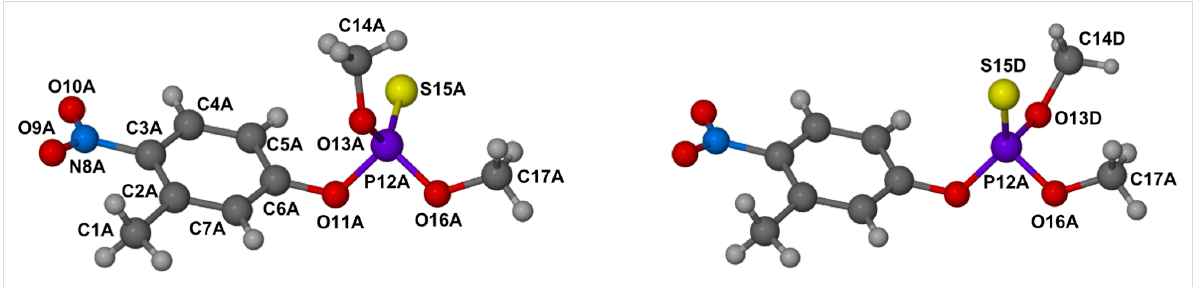
Figure 5: The rotamers of 1 occupying the cavity of host molecule A. Common atoms have labels with suffix A, while in the component on the right the alternative sulfur and methoxy group positions are labelled with suffix D. These disordered guest components (labelled A, D) have site occupan- cies 0.70 and 0.30, respectively.